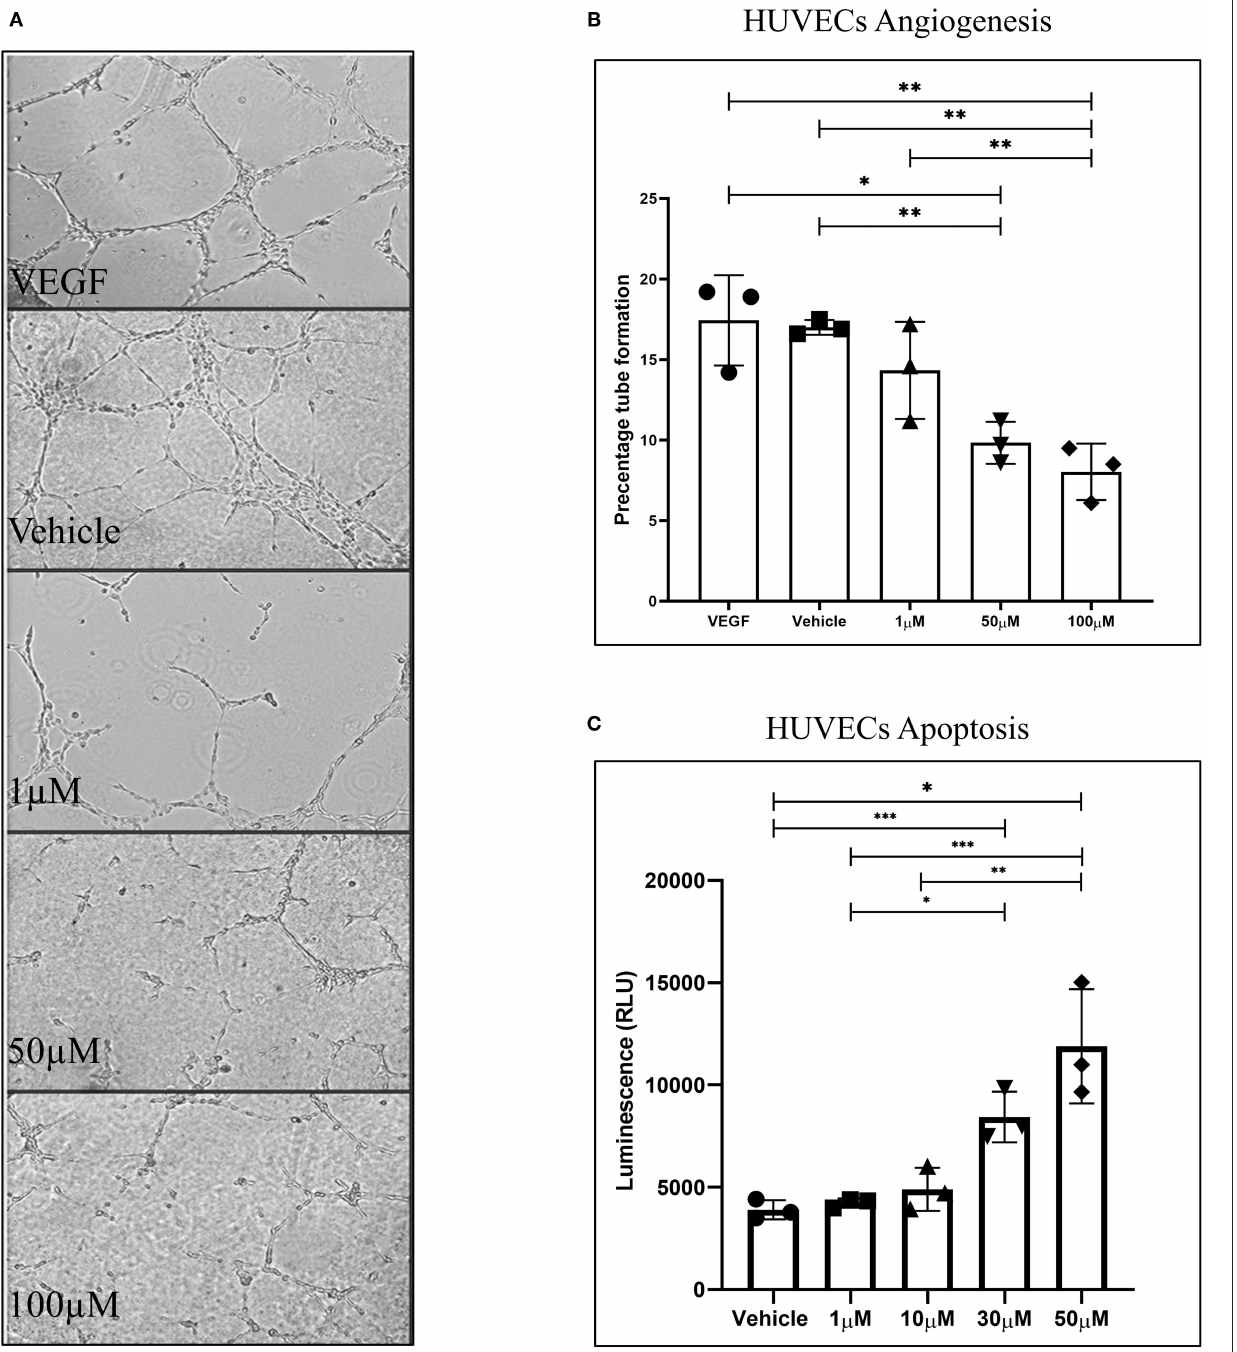
FIGURE 2 | WIN 55 exposure inhibits tube formation ability in human umbilical vein endothelial cells (HUVECs). (A) Images captured shows alteration of tube formation in concentrations as low as 1 µ M and near complete reduction in high doses. (B) The percentage of tube formation analysis showed a statistical significance across the board with a dose-dependent behavior. (C) Treatment with various doses of WIN 55 leads to dose-dependent increase in caspase activity in HUVECs. Ordinary one-way ANOVA with Tukey post-hoc . * P < 0.05 ** P < 0.01 *** P < 0.001.